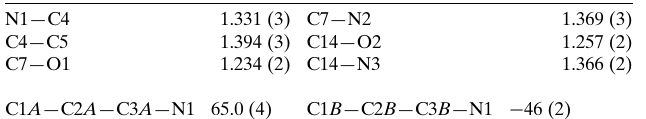
Table 2 Selected geometric parameters (A˚ , (cid:3) ) for ( II ).